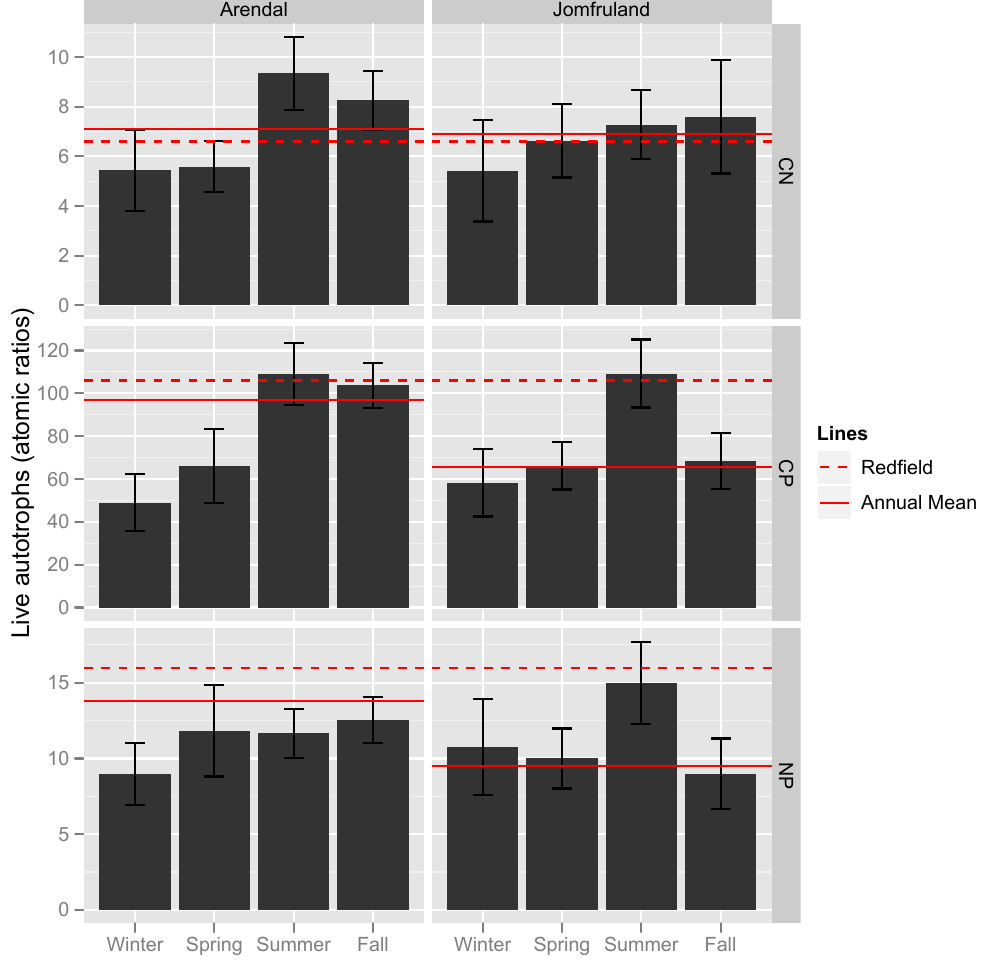
Fig. 10. Calculated C:N, C:P and N:P of live autotrophs for Arendal and Jomfruland from regression model, with lines showing annual mean ratio and the Redfield ratios. Error bars show the